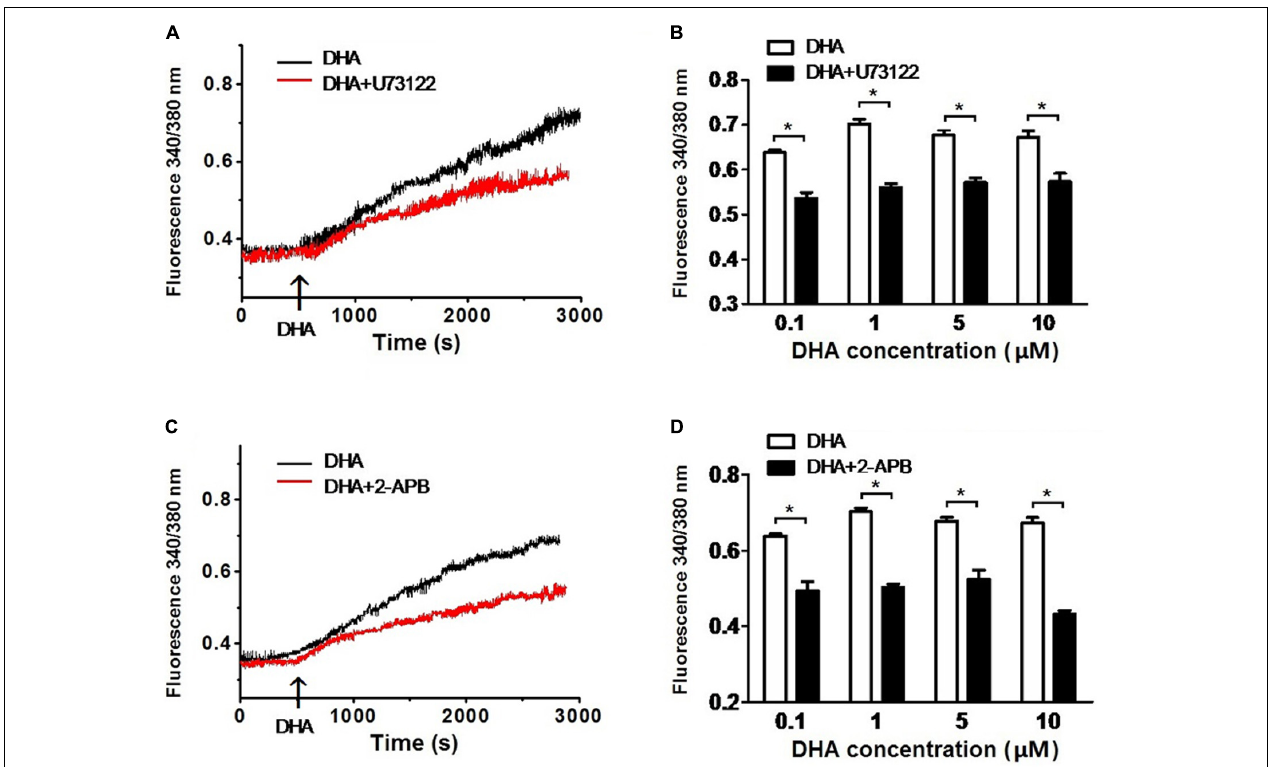
FIGURE 5 | DHA induces the increase of [Ca 2 + ] i via PLC–IP3 signal pathway. (A) Representative recordings of DHA-induced fluorescence intensity ratios in rat CASMCs with or without U-73122 pre-incubation. (B) Group data in bar graphs showing fluorescence intensity ratios after exposure to 0.1, 1, 5, and 10 µ M of DHA in rat CASMCs with or without U-73122 pre-incubation, n = 5–8 cells, ∗ P < 0.05 U-73122 vs. control. (C) Representative recordings of DHA-induced fluorescence intensity ratios in rat CASMCs with or without 2-APB pre-incubation. (D) Group data in bar graphs showing fluorescence intensity ratios after exposure to 0.1, 1, 5, and 10 µ M of DHA in rat CASMCs with or without 2-APB pre-incubation, n = 5–8 cells, ∗ P < 0.05 2-APB group vs. control